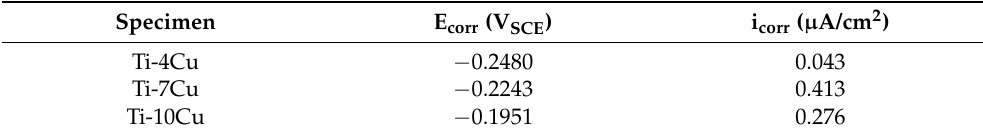
Table 5. Electrochemical parameters of the as-cast Ti-xCu